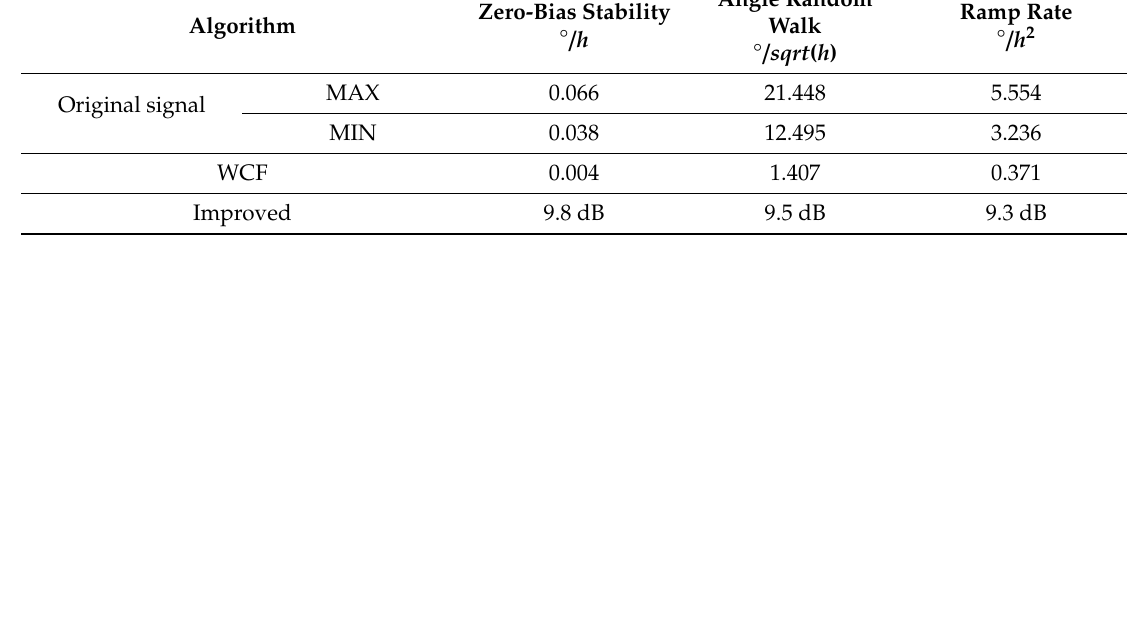
Figure 7. Optimization results of yaw angle (sky) error.